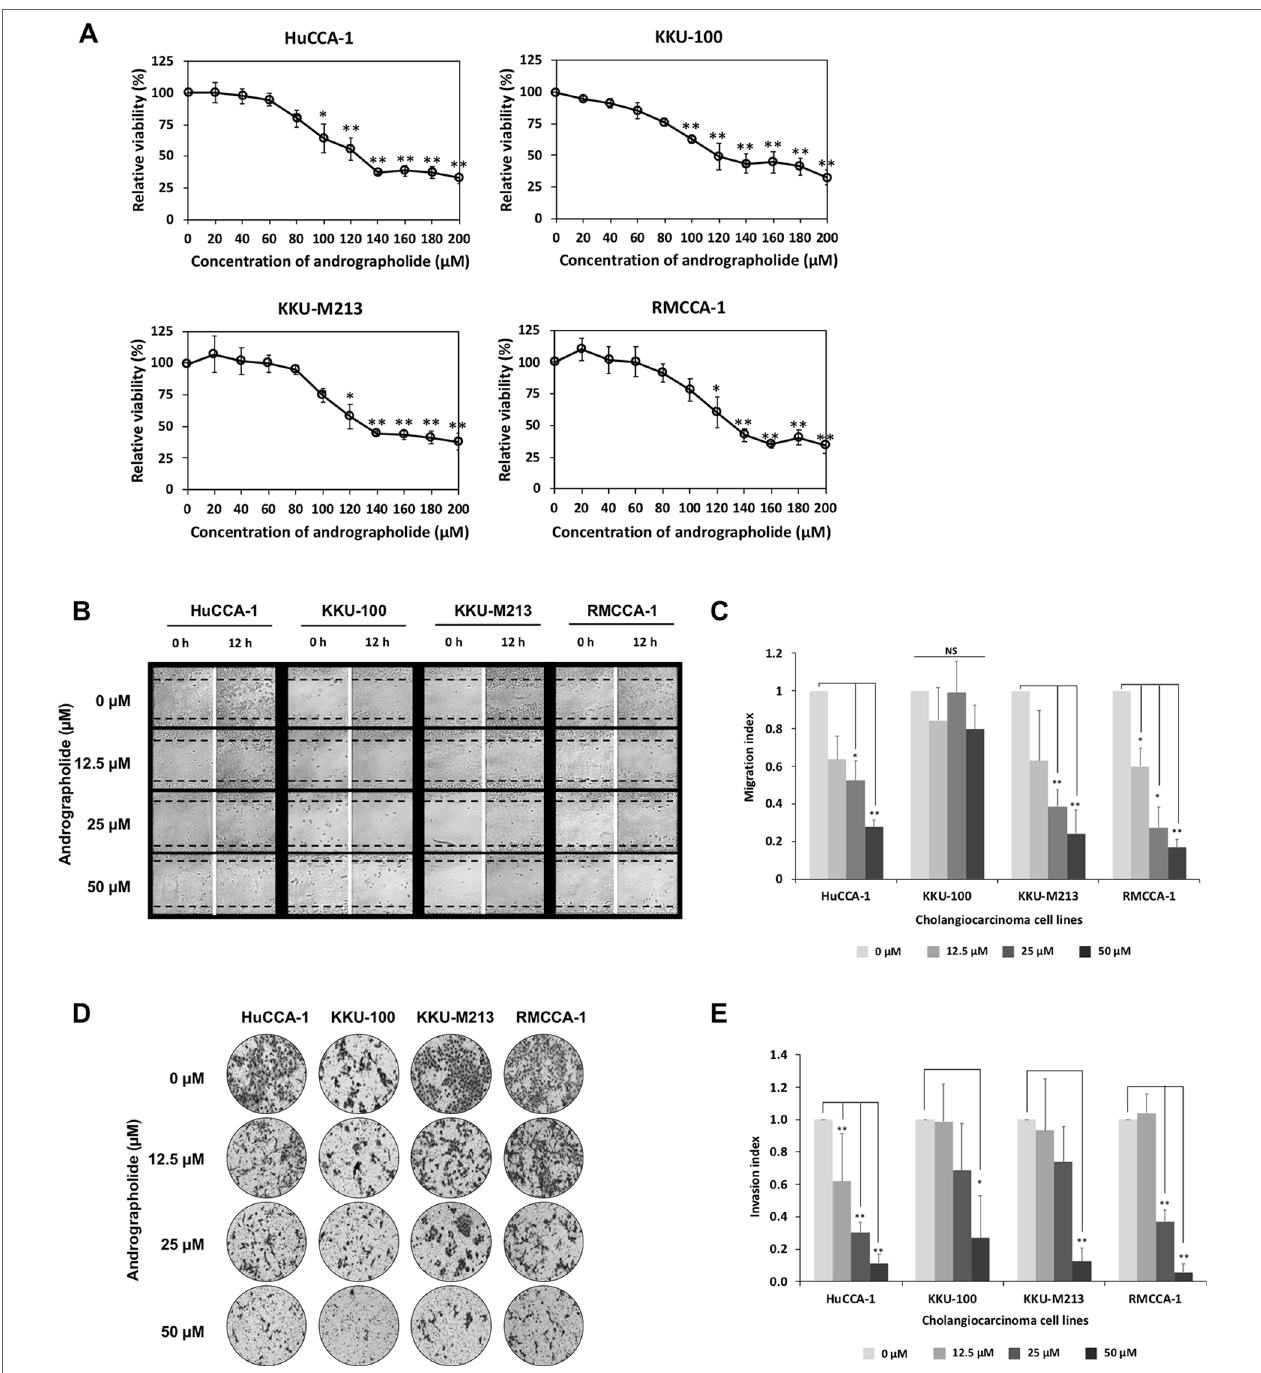
FIGURE 1 | Andrographolide inhibits cholangiocarcinoma (CCA) cell migration and invasion. (A) Effect of andrographolide on CCA cell viability. CCA cells were treated with various concentrations of andrographolide (0–200 µM) for 48 h, and cell viability was determined by 3-(4,5-Dimethylthiazol-2-yl)-2,5-diphenyltetrazolium bromide (MTT) assay. The results represented the average of percentage cell viability compared with that of the control. (B) CCA cell monolayer treated with andrographolide at the concentrations of 0, 12.5, 25, and 50 µM was scratched, and the size of the wound was photographed at 0 and 12 h following the wound scratch. (C) Migration index as indicated by quantitative assessment of wound length. The results represented the average value of migration index compared with that of the control. (D) Invasive ability of CCA cells with andrographolide treatment (0, 12.5, 25, and 50 µM) was observed using Matrigel invasion assay. After 24-h incubation, the invasive cells were photographed. (E) The number of invasive cells were counted and calculated to invasion index. The results showed the average invasion index compared with that of the control. Data were presented as mean ± SE, which were derived from three independent experiments, * p < 0.05, ** p <